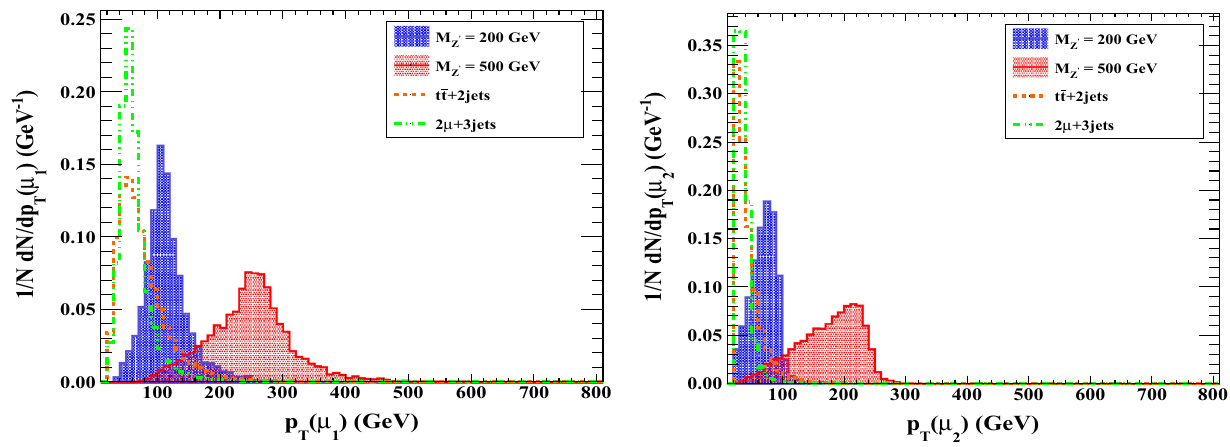
Fig. 5 Normalized transverse momentum ( p T ) distributions of the leading (left) and sub-leading (right) muons for the signal ( M Z (cid:2) = 200 and 500 GeV) and relevant SM backgrounds. The values of g μμ and g bb are 0.20(0.48) and 4 . 2 × 10 − 3 ( 1 . 10 × 10 − 2 ) for M Z (cid:2) = 200 ( 500 ) GeV,